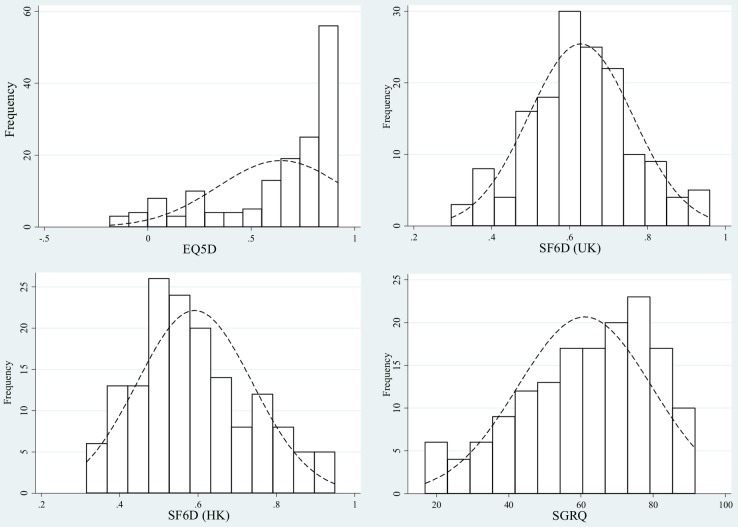
Distribution of EQ-5D, SF-6D (UK), SF-6D (HK) and SGRQ scores.